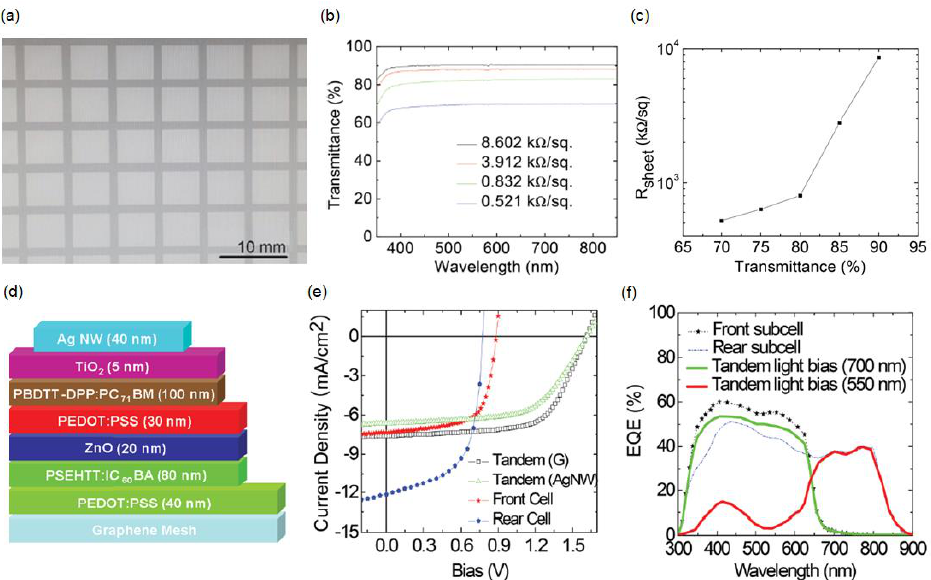
Figure 4. ( a ) Top-view SEM image of the graphene mesh; ( b ) Transmission spectra of the graphene mesh with the different sheet resistances; ( c ) Sheet resistance of the graphene mesh with respect to the light transmittance at 550 nm for various graphene mesh thicknesses; ( d ) Schematic of the semitransparent tandem cell; ( e ) J – V characteristics of front, rear, and tandem cells (light projected from the graphene mesh or Ag nanowires (NWs)); ( f ) EQE profiles measured under relevant bias illumination conditions. Reproduced with permission [90]. Copyright 2014, Wiley.